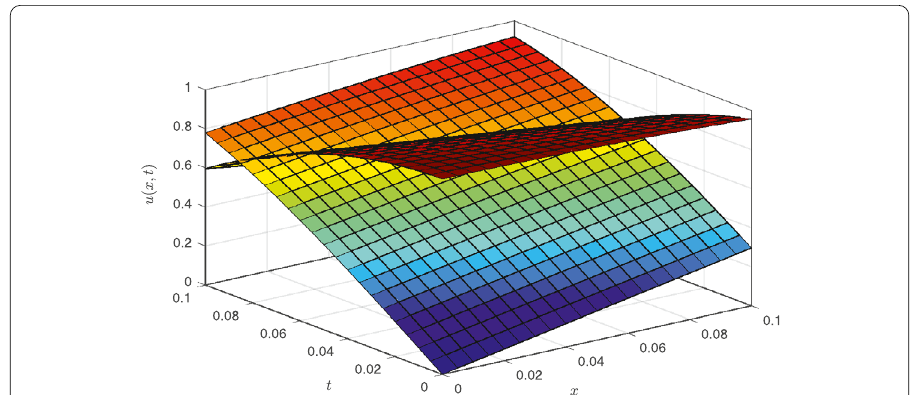
Figure 1 The approximate solution of Example 1 for Case 1 and α = β = 1